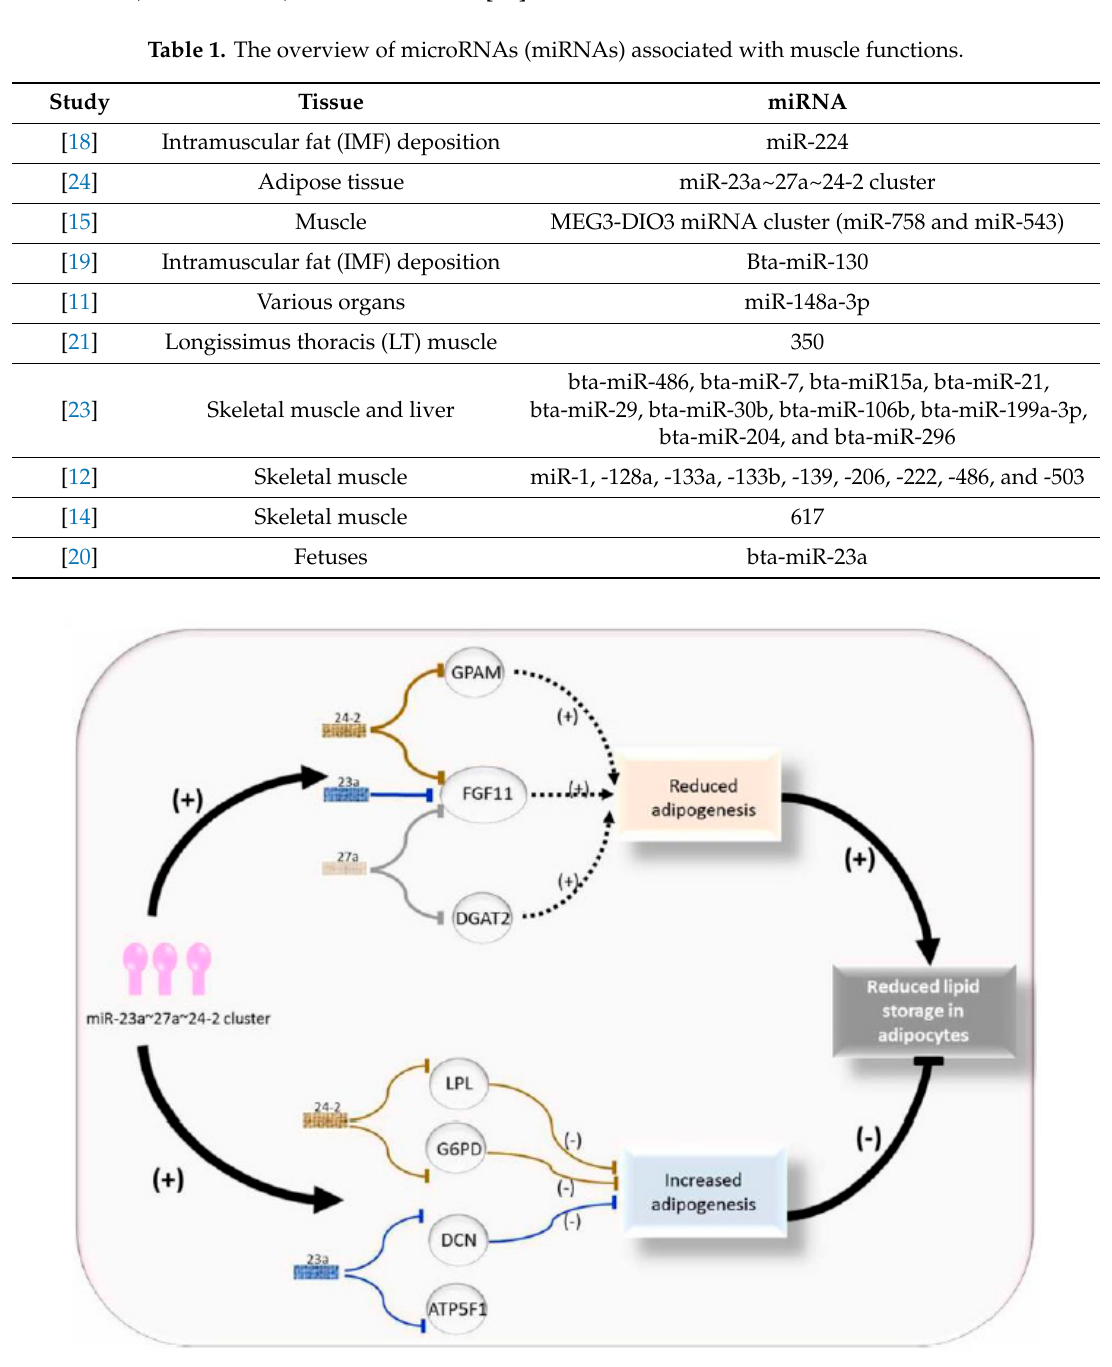
Figure 2. Role of the miR-23a~27a~24-2 cluster in regulating adipocyte